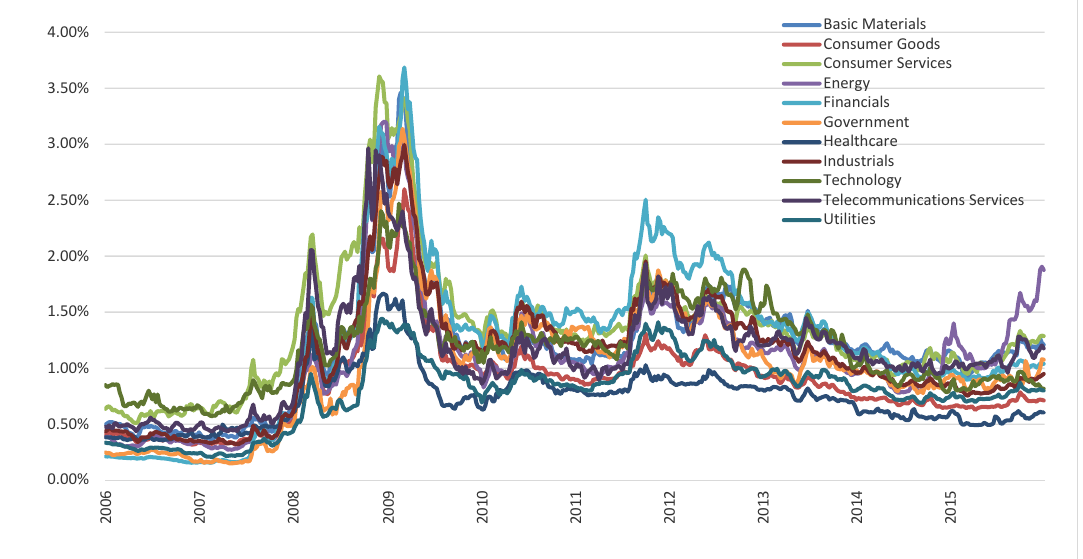
Figure 1. Sectorial CDS spreads 2006–2015. The figure shows our estimated sectorial CDS indices. Weekly data: January 2006–December